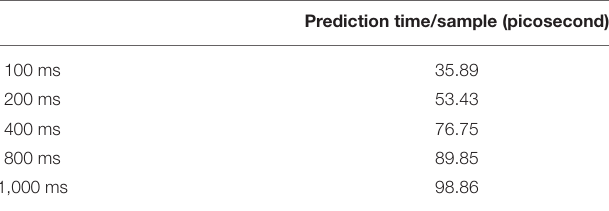
TABLE 5 | Average prediction time per sample of the proposed deep neural network